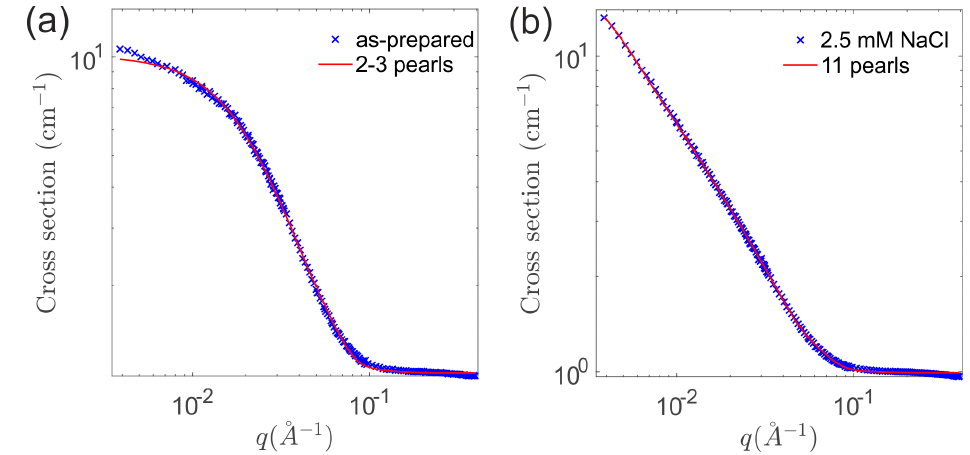
Figure 6. Small angle neutron scattering (SANS) measurements on liquid samples of hematite nanoparticles. ( a ) As-prepared; ( b ) in 2.5 mM NaCl. Blue crosses are data points. Red line is fit to data.